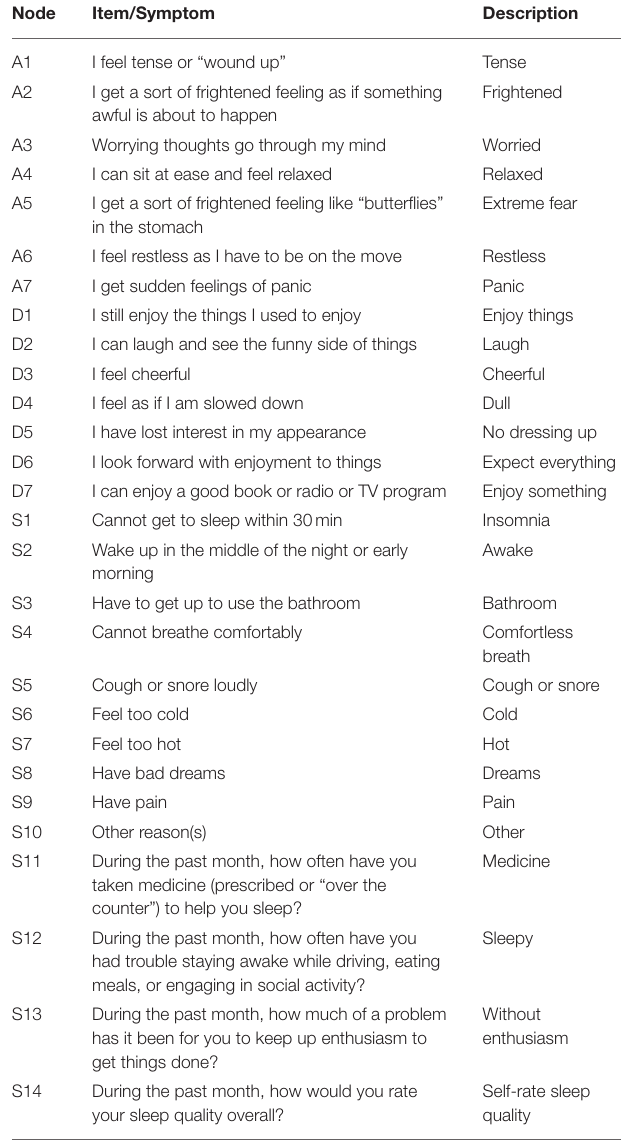
TABLE 1 | Study items in the hospital anxiety and depression scale questionnaire and the pittsburgh sleep quality index